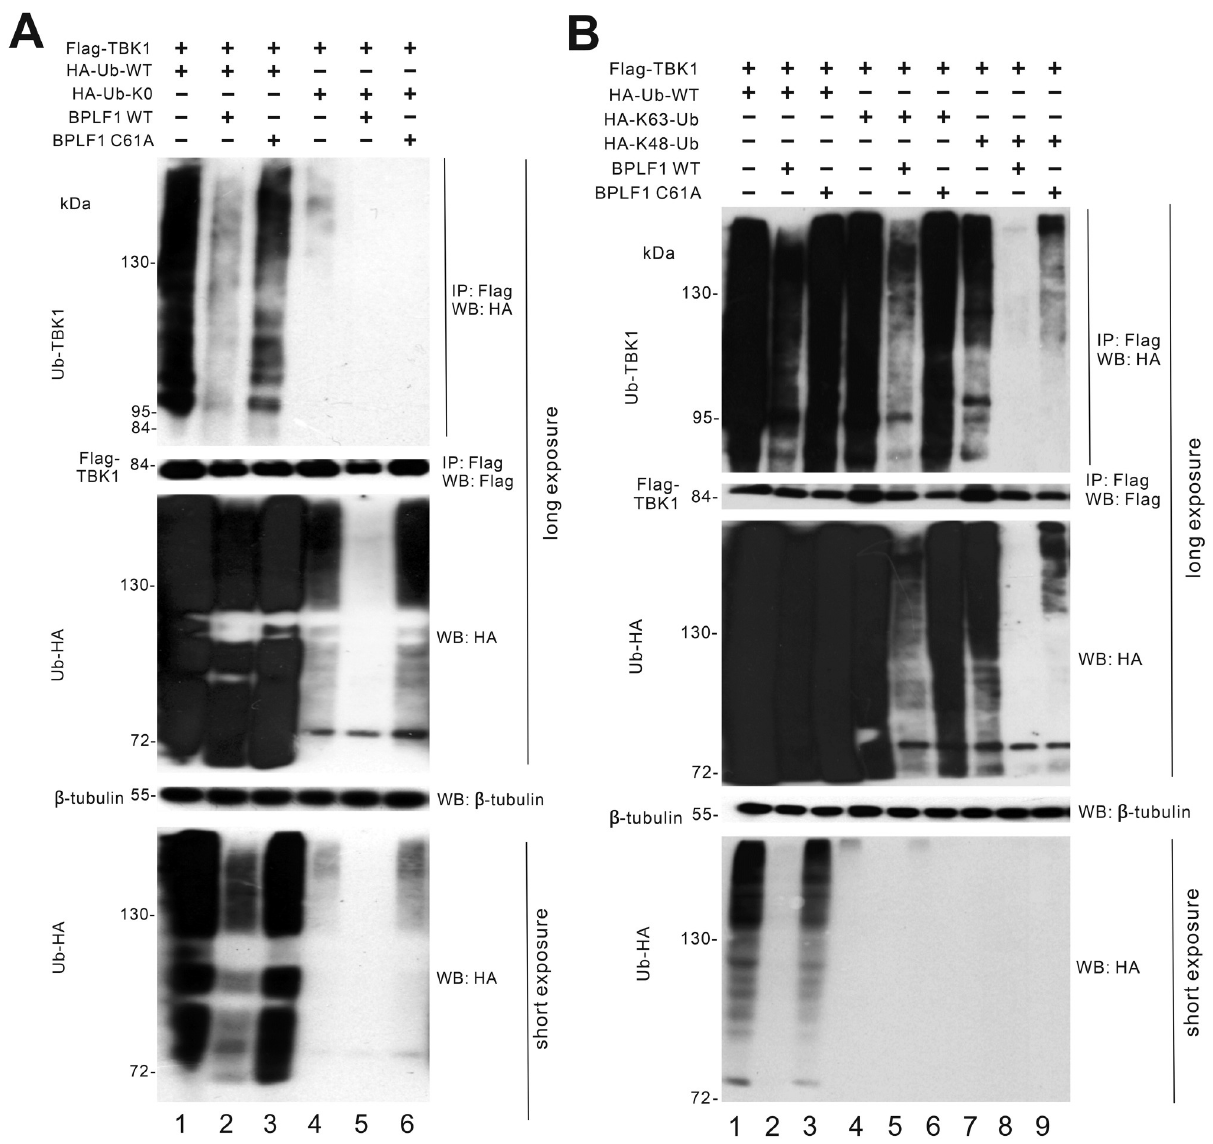
Fig 5. BPLF1 perturbs TBK1 ubiquitination. (A) Influence of BPLF1 and C61A on TBK1 ubiquitination. BPLF1, C61A and TBK1 expression plasmids were transfected into HEK293T cells together with HA-Ub-WT and lysine-free ubiquitin (HA-Ub-K0). (B) Influence of BPLF1 and C61A on TBK1 ubiquitination of different types. BPLF1, C61A and TBK1 expression plasmids were transfected into HEK293T cells together with HA-Ub-WT and HA-K63-Ub and HA-K48-Ub. Cells were harvested 24 hours after transfection for co-immunoprecipitation. The Flag-tagged TBK1 molecules were pulled down by anti-Flag antibodies. The bound fraction of the immunoprecipitates (IP) and the total lysates (input) were analyzed by Western blotting (WB) with anti-HA, anti- Flag and anti- β -tubulin antibodies. Long exposure was conducted for visualizing proteins in the upper panel and short exposure was conducted for visualizing proteins in the lower